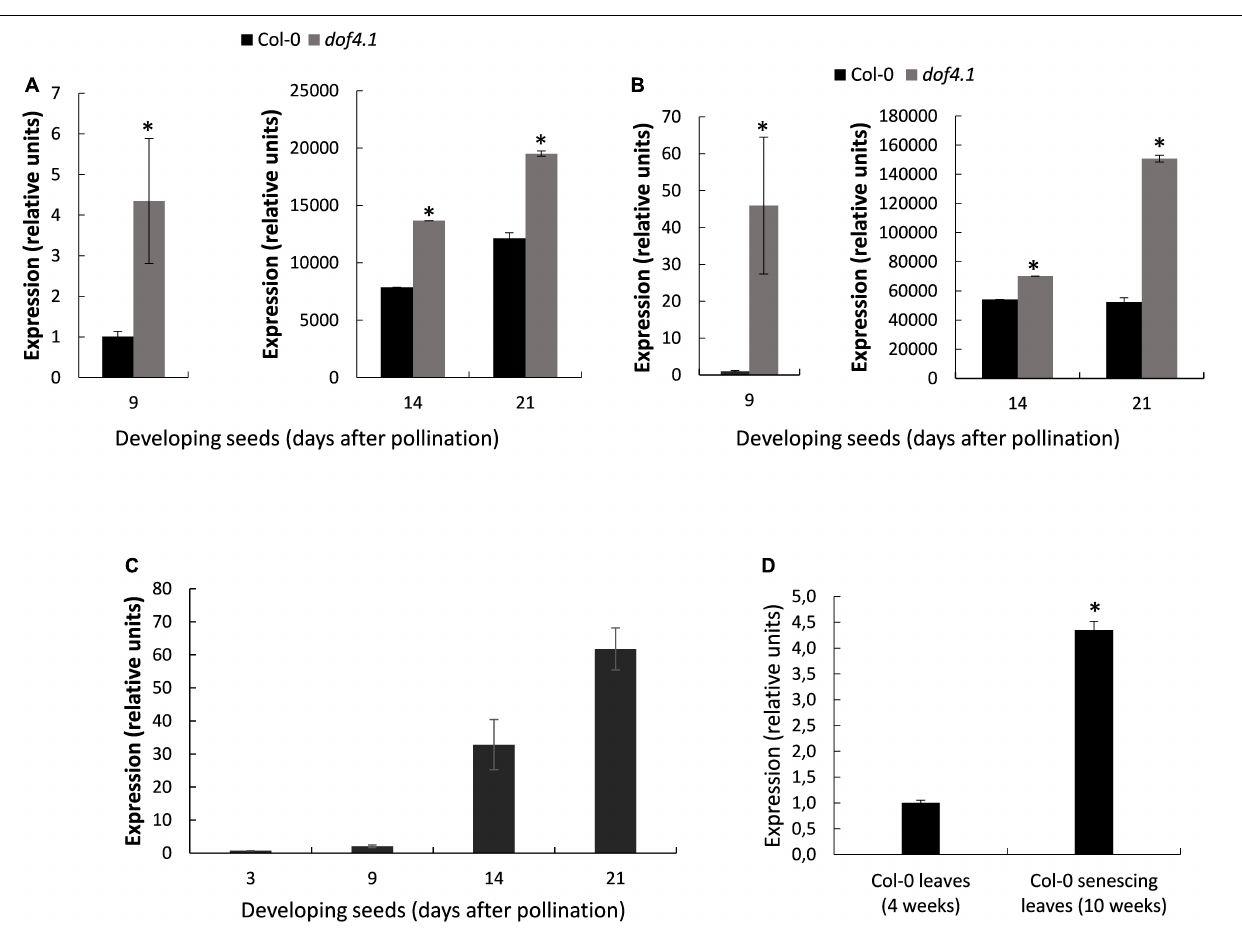
FIGURE 4 | SSPs expression levels during seed development and dof4.1 expression in developing seeds and senescing leaves. Expression levels of cruciferins (A) and napins (B) were determined by real-time quantitative PCR (qRT-PCR) in developing seeds (9, 14, and 21 DAP) of Col-0 and dof4.1-3 . (C) Expression level of DOF4.1 was determined by qRT-PCR in developing seeds (3, 9, 14, and 21 DAP) and in senescing leaves (10 weeks after transferring to soil) compared to non-senescing leaves (4 weeks after transferring to soil) (D) . Data are the mean of three replicates. Significantly differing from Col-0 at P < 0.05 ( ∗ ) using Student’s t -test. Col-0 = Columbia 0. DAP, Days After